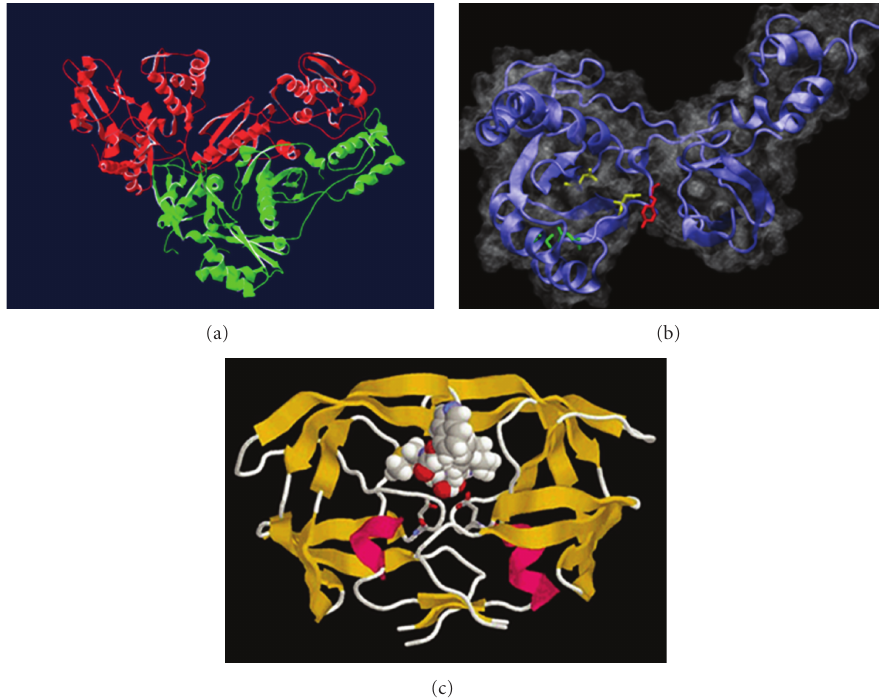
Figure 3: Tertiary structure of RT, IN, and PR: (a) RT: p66 in red and p51 in green; (b) catalytic core of IN in blue. Aminoacid 143 in red, 97 and 120 in green, and 64 and 116 in yellow. (c) Dimeric PR in complex with a protease inhibitor.